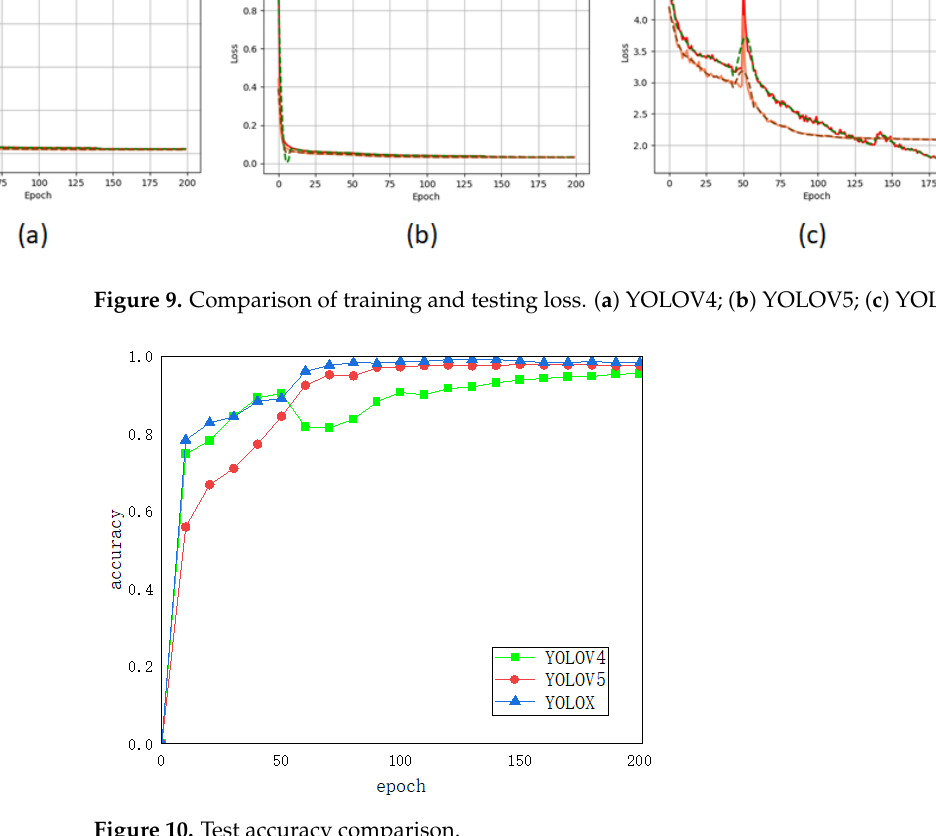
Figure 10. Test accuracy